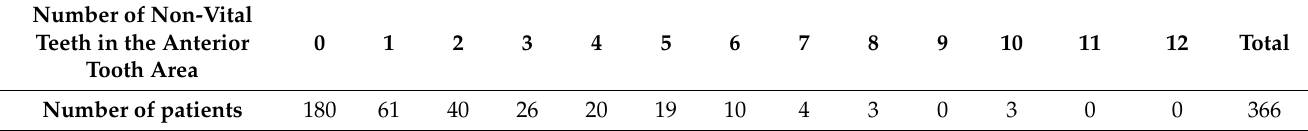
Table 4. Number of patients by number of non-vital teeth in the anterior tooth